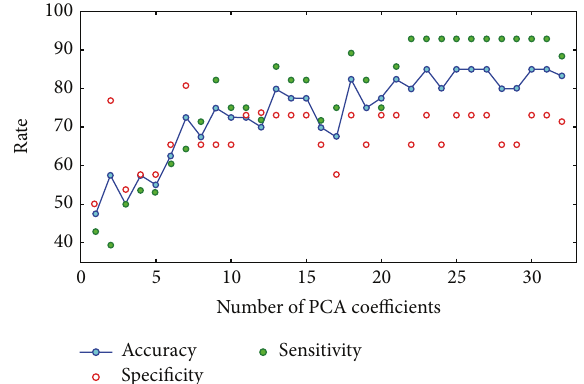
Figure 3: Accuracy, Specificity, and Sensitivity of classification as a function of the number of employed PCA coefficients for the ED versus HC group discrimination (20-fold